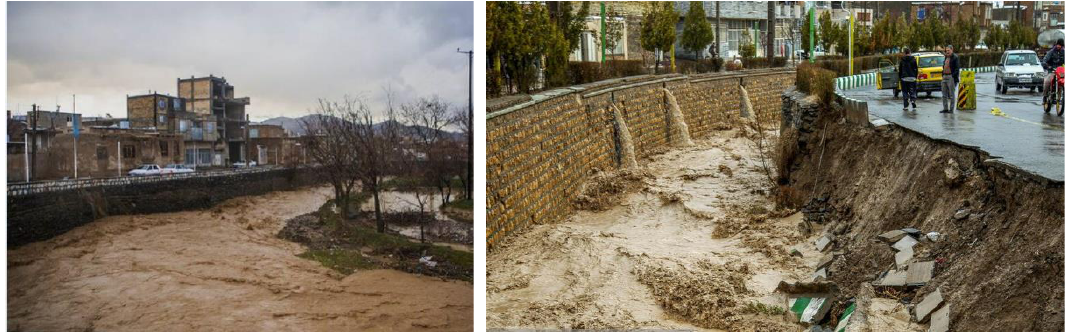
Figure 2. Flash flooding in Tafresh city.